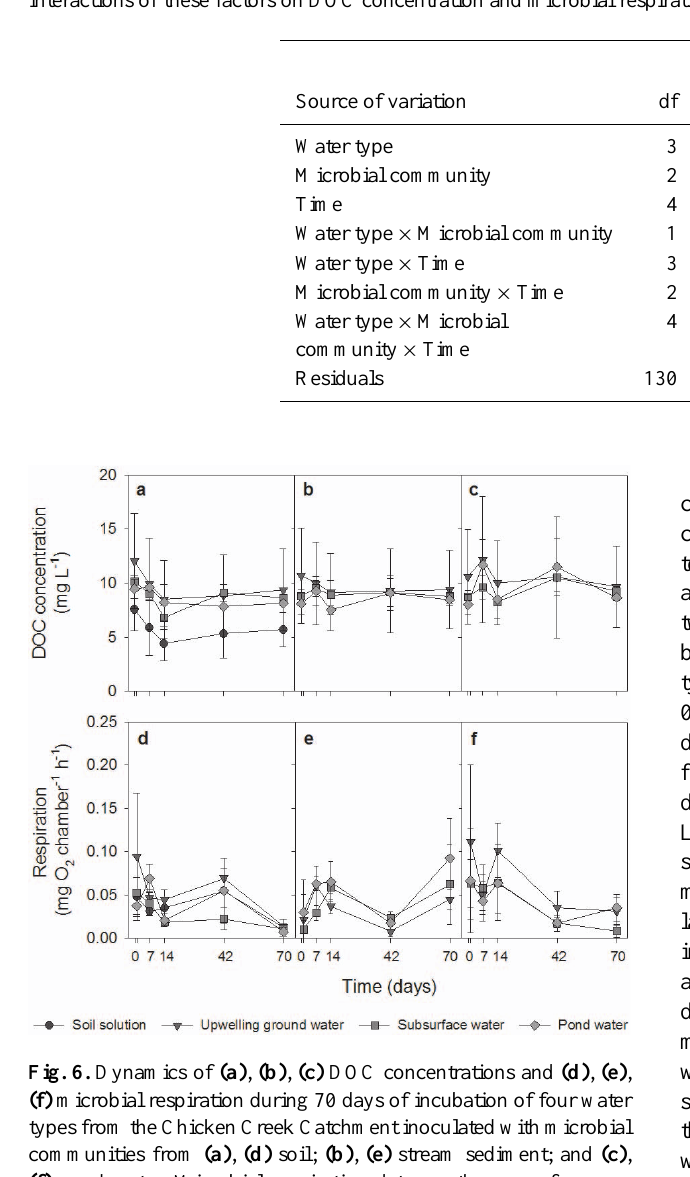
Table 3. Three-factorial permutation ANOVA (5000 permutations) testing for the effects of water type, microbial community, time and interactions of these factors on DOC concentration and microbial respiration. df=degrees of freedom; MS=mean sum of squares.